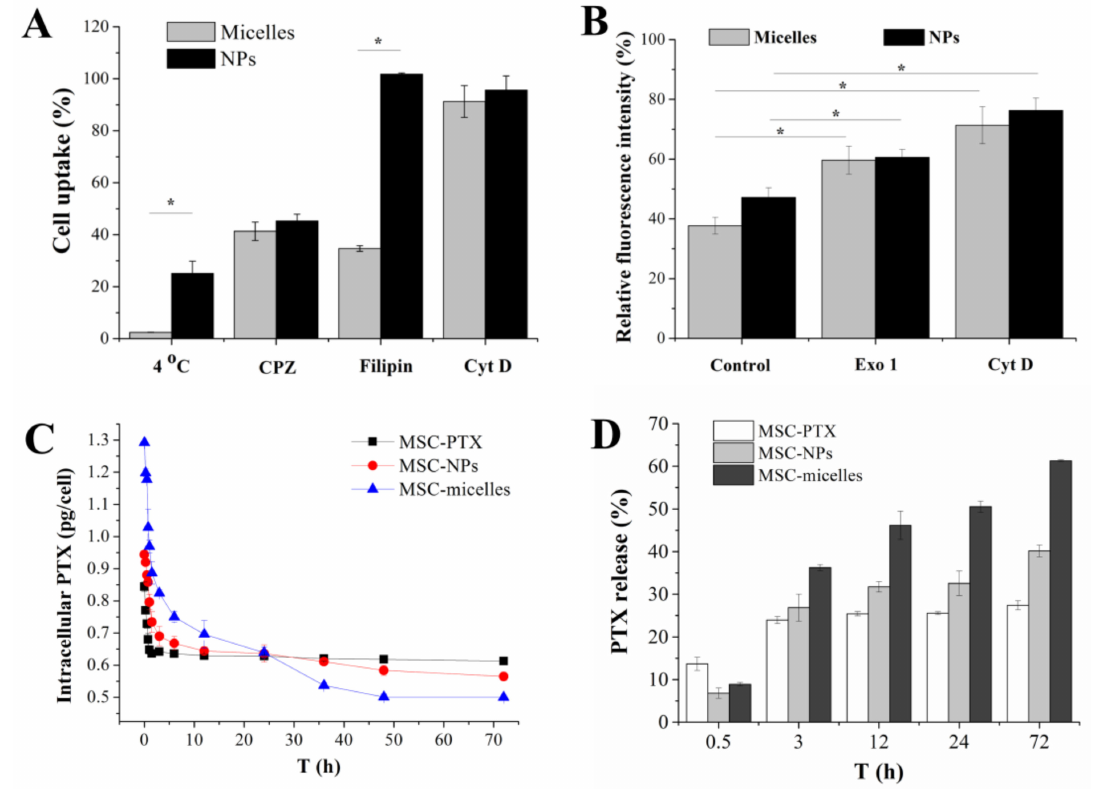
Figure 3. ( A ) Relative uptake of coumarin 6/PLGA NPs and coumarin 6/HA-PLGA micelles in MSCs pre-incubated at 4 ◦ C or with three endocytic inhibitors, 10 µ g/mL CPZ, 1 µ g/mL filipin III, and 1 µ g/mL Cyt D. The intracellular fluorescence intensity of coumarin 6/PLGA NPs and